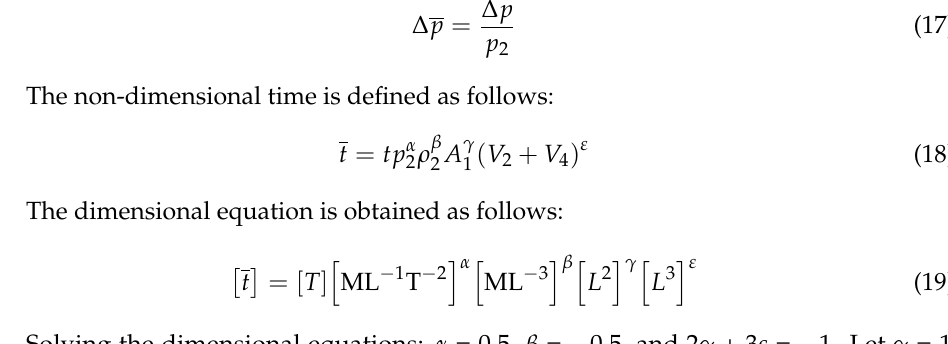
Table 1. Dimension of parameters. Parameter Dimension Pressure of cabin, cockpit ( p 2 , p 4 ) and environment ( p 0 ) Density of cabin, cockpit ( ρ 2 , ρ 4 ) and environment ( ρ 0 ) Area of the windshield ( A 1 ) Total volume of compartments ( V 2 + V 4 ) Decompression load ( ∆ p